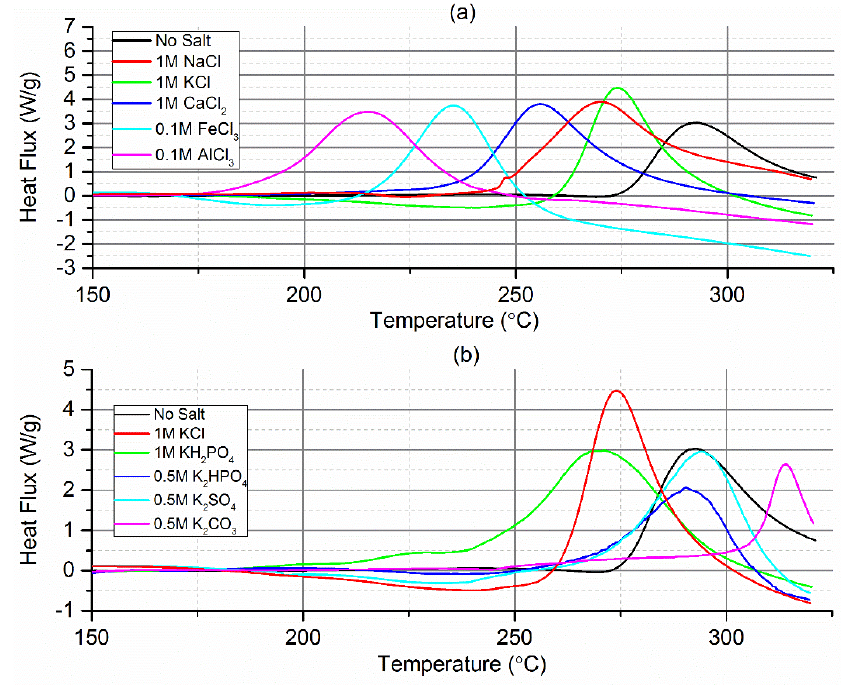
Figure 1. DSC thermograms of the HTC of cellulose in the presence of metal salts. ( a ) Influence of chloride salts, and ( b ) influence of potassium salts.